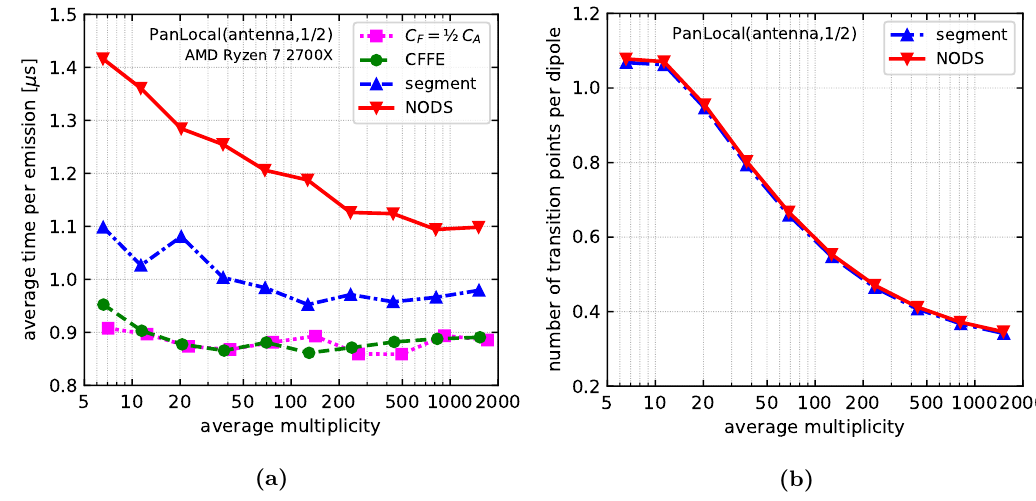
Figure 13. (a) Time per emission plotted as a function of the average multiplicity, N , in the event sample, for different colour schemes. To maximise the relative impact of the colour scheme timing penalty, results are shown for one of the most optimised of our shower setups, the PanLocal antenna shower with β = 1 , run with fixed coupling. Additional details are given in the text. 2 (b) The average number of transition points per dipole in the segment and NODS methods, as a function of the average